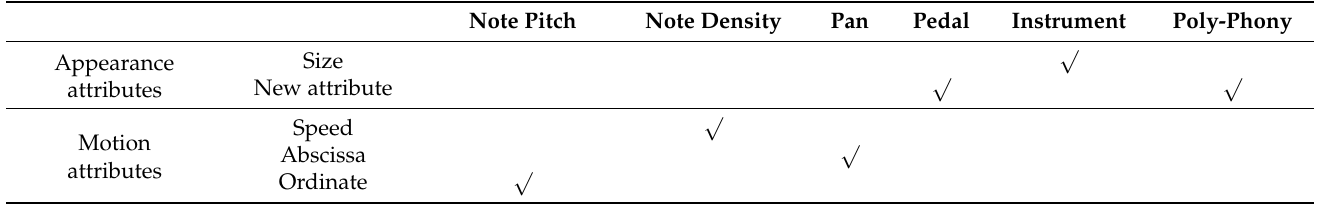
Table 1. The mapping relationship between object attributes and MIDI attributes. Note Pitch Note